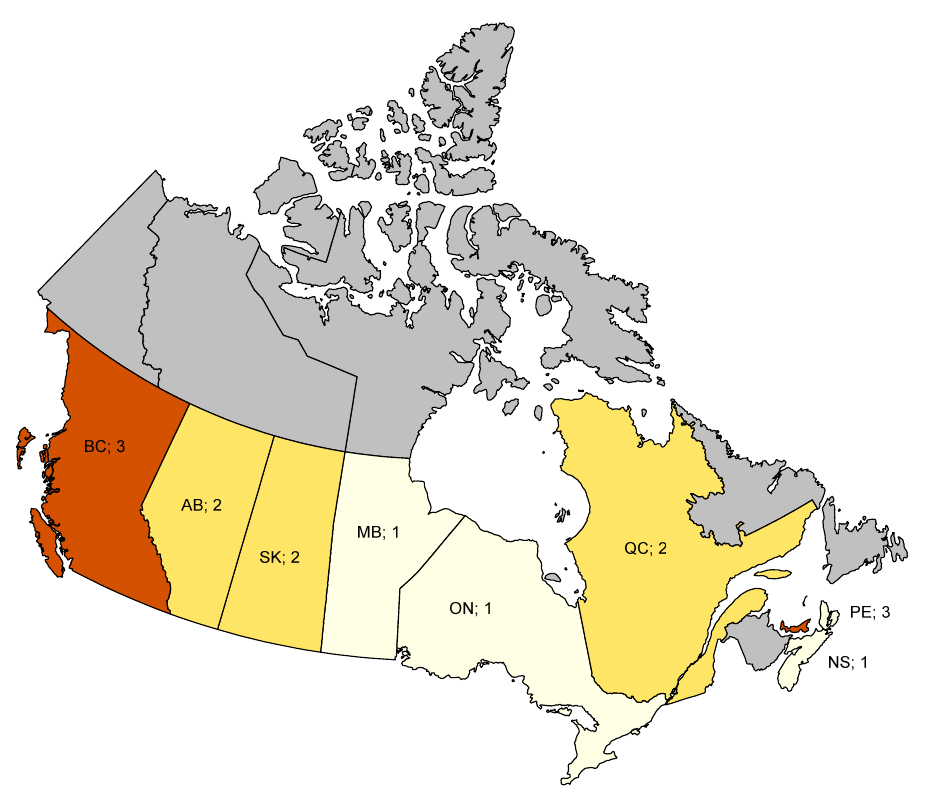
Figure 3. COVID-19 restrictions by province. The figure shows the level of ‘normal’ operations permitted in each respective province for May 2021. Level 1: No public mass. Level 2: Public mass at 10–30 people. Level 3: Public mass at 50% capacity. Source: Information gathered from Church authorities in participating provinces.